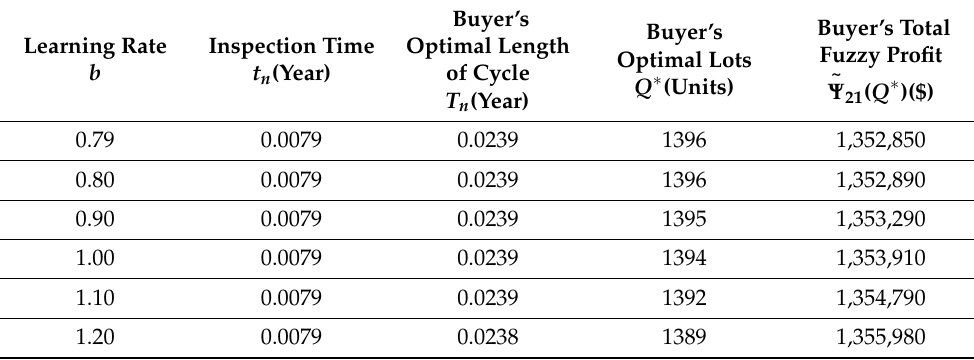
Table 4. Effect of learning rate on order quantity, inspection time and buyer’s profit under learning effect.